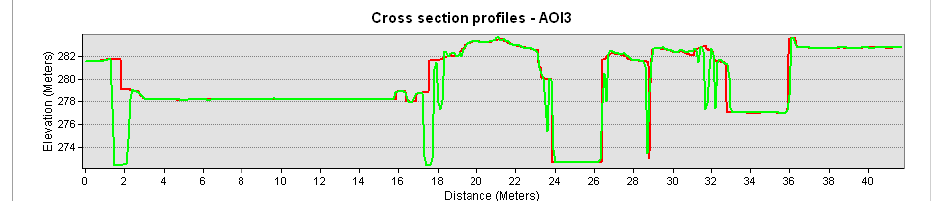
Figure 12. Vertical cross section of DSM obtained from photogrammetric software shown in Red and from Enhanced DSM obtained from research methodology shown in Green for the AOI3 region.